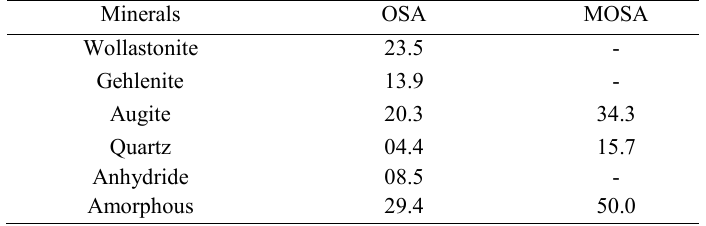
Table 3. Mineralogical analysis of Timahdet OSA and MOSA (% w/w). Minerals